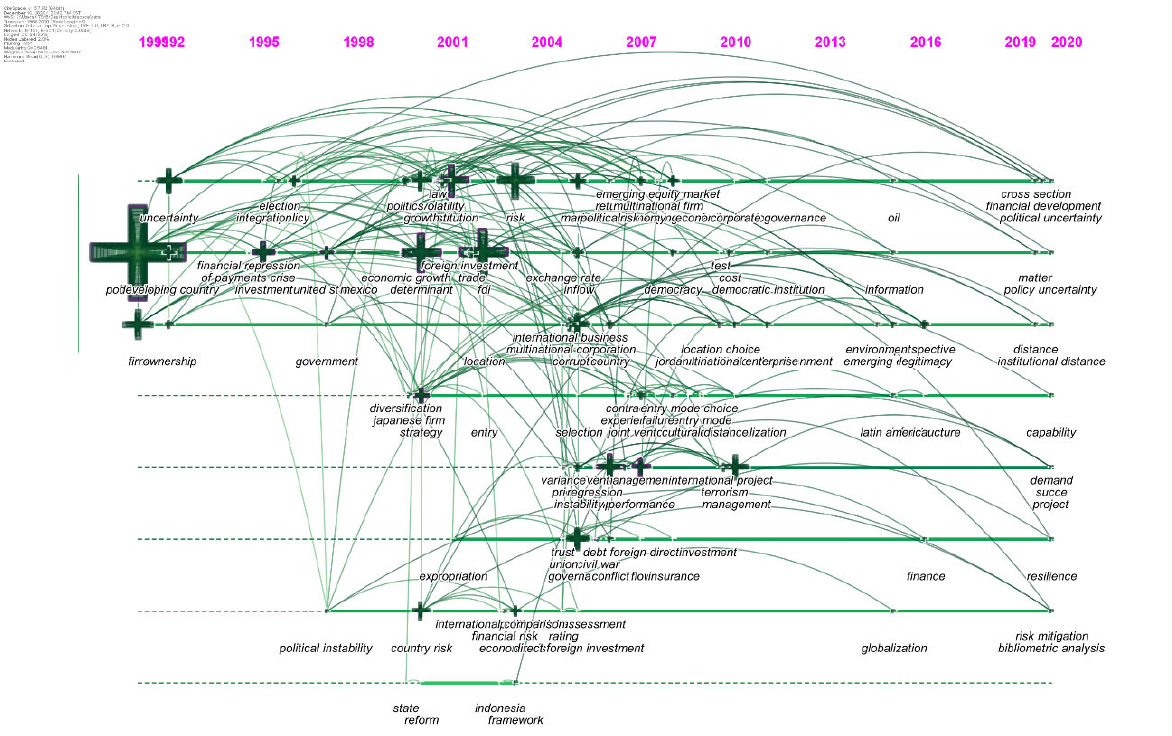
Fig. 10. A timeline view of keyword co-occurrence network: